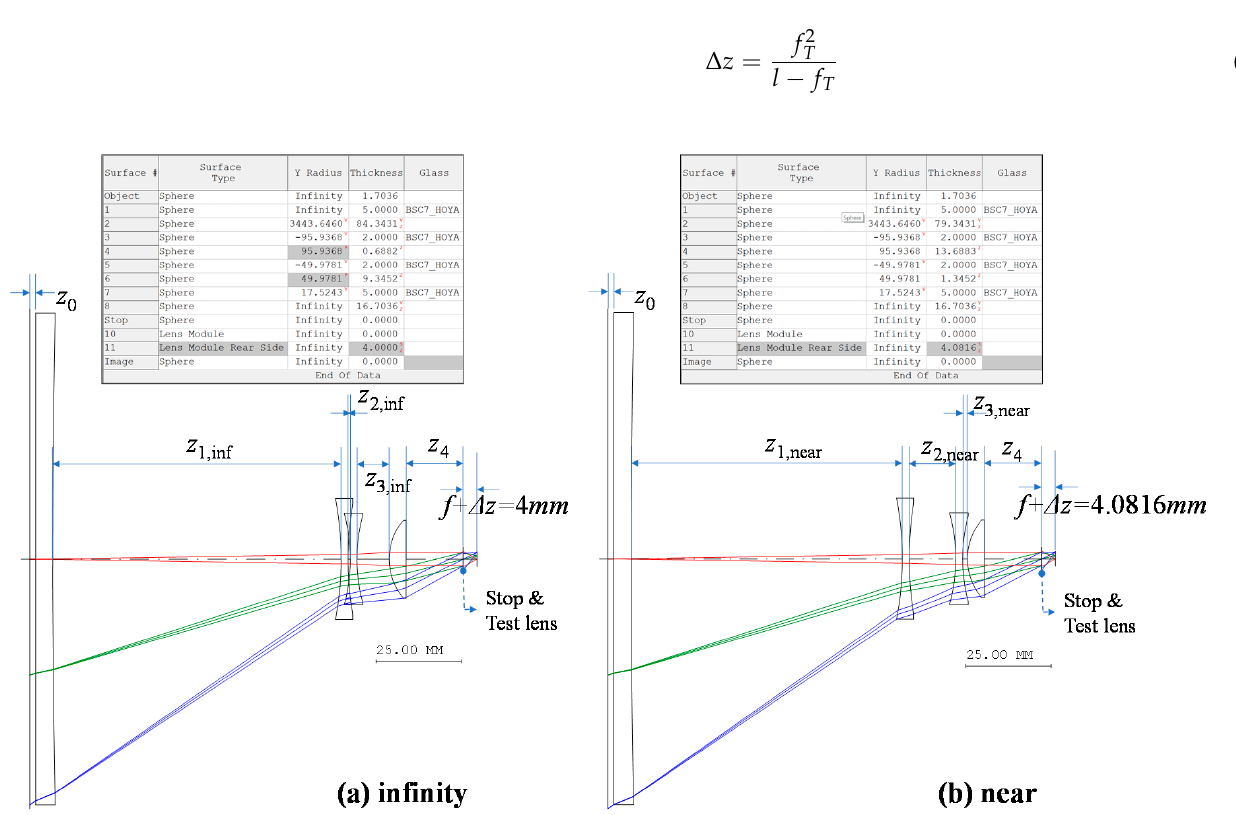
Table 2. The solutions for Equations (3) and (4).